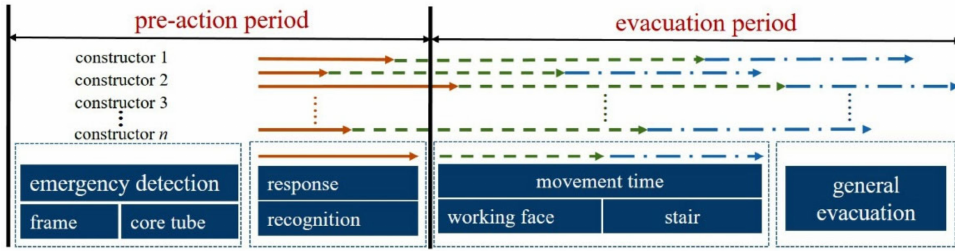
Figure 6. Evacuation process of